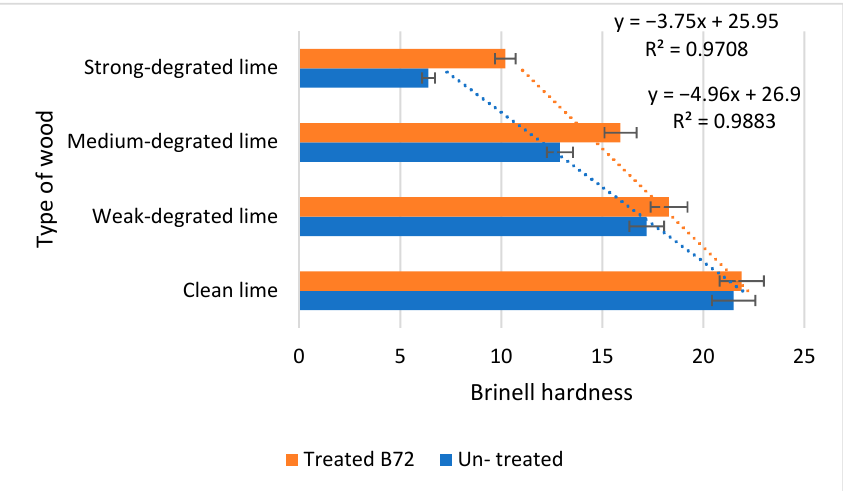
Figure 9. Brinell hardness of new and old degraded lime specimens, treated and untreated B72. The degree of fragility-degradation in the case of Brinell hardness, determined with Equation (6), for slightly degraded lime wood was 20% for no-treated samples and 14.8% for lime treated with B72. In the case of medium-degraded specimens, the degree of fragility-degradation was 40% when the specimens were not treated and 26% when the specimens had B72 consolidation treatment. In highly degraded specimens, the degree of fragility-degradation was 70.2% when the specimens were not treated and 52.5% when treated with B72. In conclusion, the degradation-fragility values were identified by the Brinell method as 15–25% in case of light degradations, 30–45% in case